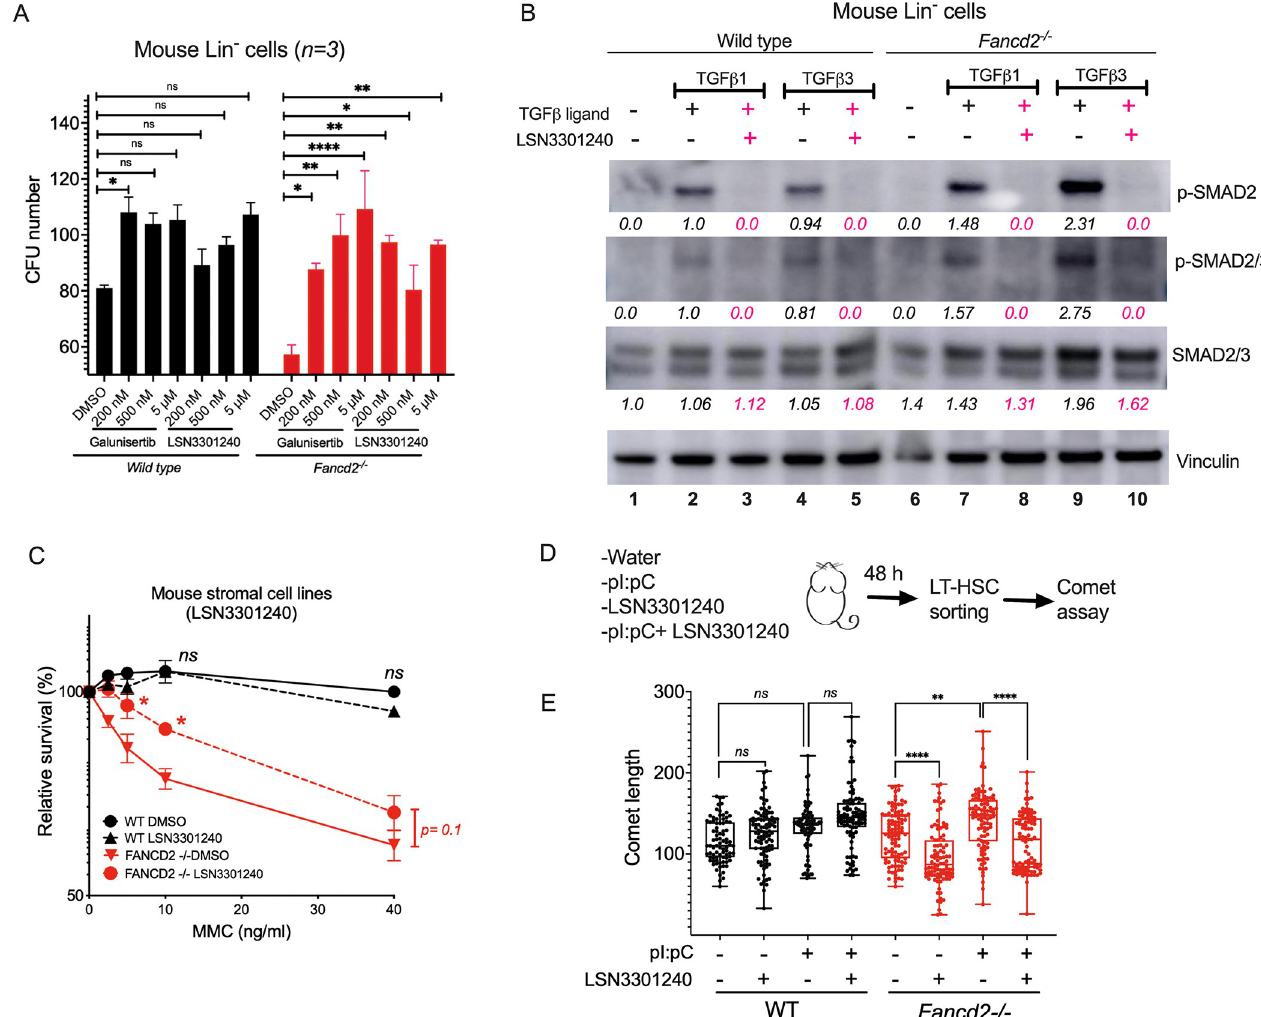
Fig 1. TGF β pathway inhibitors rescue hematopoiesis in FA models. (A) TGF β pathway inhibitors Galunisertib and LSN3301240 increase the clonogenic capacity of Lin - cells from bone marrow of Fancd2 -/- mice measured in a CFU assay. Lineage negative primary bone marrow cells from wild-type (WT) or Fancd2 -/- mice were cultured in methylcellulose medium containing increasing doses of Galunisertib or LSN3301240 for 7 days and hematopoietic colonies (CFUs) were counted for evaluating clonogenic growth of progenitors. (B) Western blots of the lysates from Lin − cells from bone marrow of wild-type and Fancd2 -/- mice cultured for 2 hours in the presence of TGF β 1 (5 ng/mL) or TGF β 3 (5 ng/mL) with or without LSN3301240. Levels of phospho-Smad2 (measured by two different antibodies, one against phospho-Smad2 and the other against both phospho-Smad2 and Smad3) are shown. Quantification relative to basal conditions and the loading control is shown below every lane. Pink indicates samples treated with LSN3301240. (C) Stromal cell lines generated from WT and Fancd2 -/- mice were cultured in the presence of LSN3301240 and Mitomycin C (MMC) and survival was determined. LSN3301240 partially rescued the MMC sensitivity characteristic of FA cell lines. (D) Schematics showing treatment of WT and Fancd2 -/- mice in vivo with pI:pC + LSN3301240. Wild-type (WT) or Fancd2 -/- mice (KO) were injected with pI:pC along with LSN3301240 and 48 hrs after the exposure, DNA damage was analyzed in bone marrow LT-HSCs using a comet assay. (E) Comet assay on sorted LT-HSCs showing that pI:pC increases the DNA damage, measured by tail length, of LT-HSCs, whereas co-treatment with LSN3301240 reduces DNA damage in LT-HSCs from Fancd2 -/- mice. Data in (A) and (C) are represented as mean ± SEM. Data in (E) are represented as boxplots. p values of 0.01 to 0.05 were considered significant ( � ), p values of 0.001 to 0.01 were considered very significant ( �� ) and p values of < 0.001 were considered extremely significant ( ��� , ���� ). See also S1